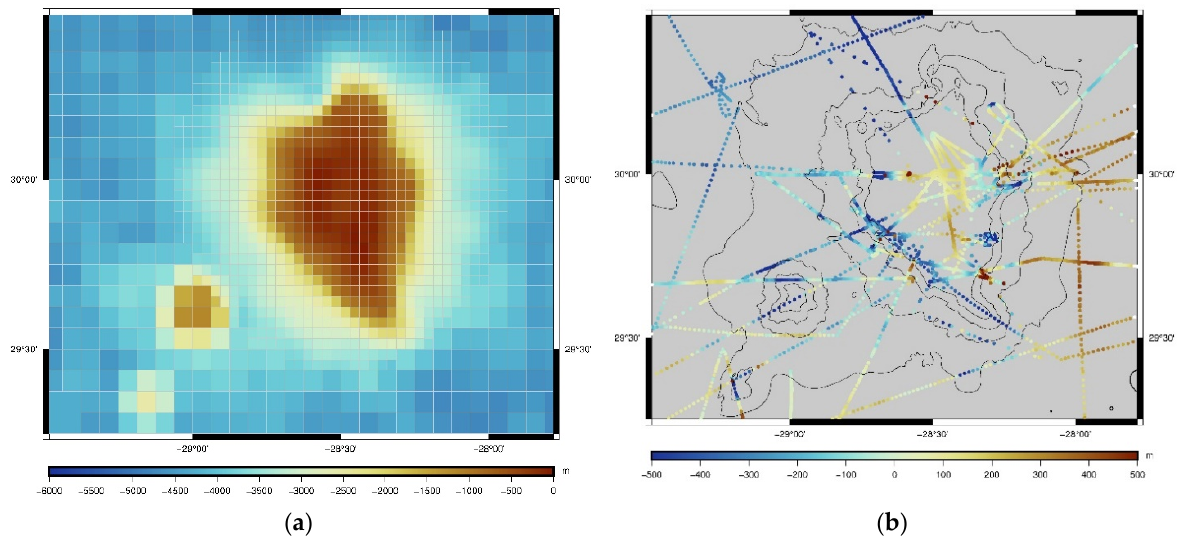
Figure 13. ( a ) Irregularly-sampled grid inversion of GEOID + FAA compensated case; ( b ) Differences between EKF estimates and bathymetry from ship-track soundings (RMS 401.9 m).